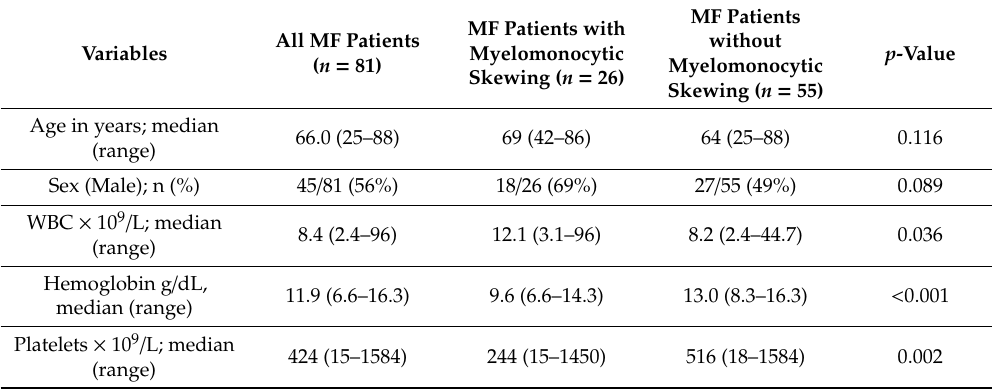
Table 1. Phenotypic characteristics of 81 patients with myelofibrosis stratified by whether or not they had myelomonocytic skewing in semisolid cultures.